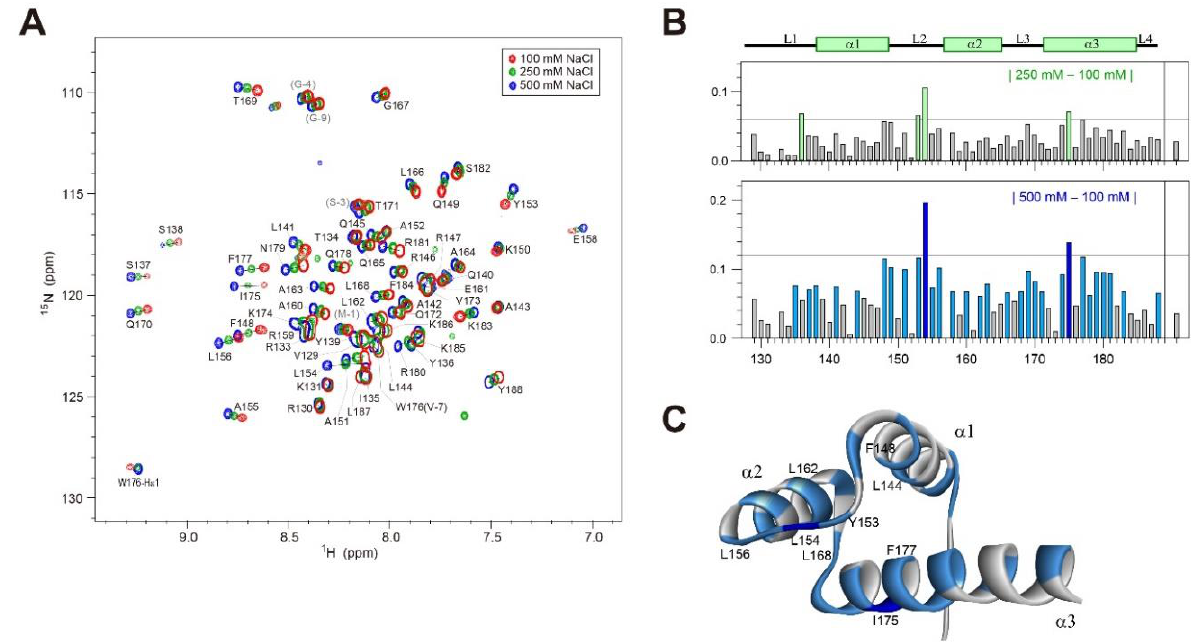
Figure 3. ( A ) Superposition of 1 H/ 15 N-HSQC spectra of free Dlx3-HD at 100 mM (red), 250 mM (green), or 500 mM NaCl (blue) at 35 ◦ C. ( B ) The average chemical shift differences ( ∆ δ avg ) between [NaCl] of 100 and 250 mM (upper) and of 100 and 500 mM (lower) for free Dlx3-HD at 35 ◦ C. ( C ) Mapping the location of the residues with a large ∆ δ avg between [NaCl] of 100 and 500 mM onto the structure of free Dlx3-HD. The colors used to illustrate the ∆ δ avg are blue (>0.12 ppm) and light blue (0.06–0.12